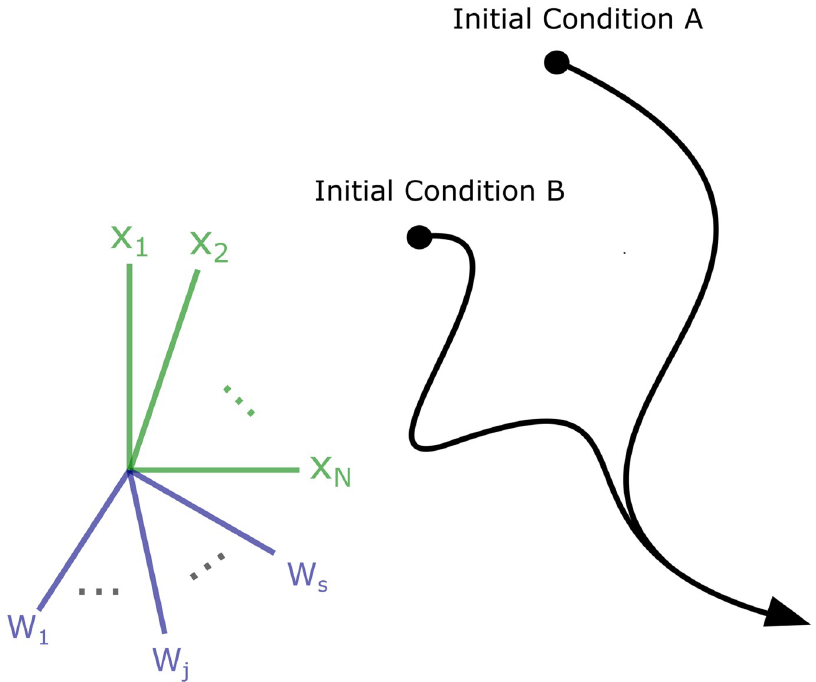
Fig 1. Cartoon demonstrating the contraction property. In a network with N neural units and S dynamic synaptic weights, the network activity can be described a trajectory over time in an ( N + S )-dimensional space. In a contracting system all such trajectories will converge exponentially in some metric towards each other over time, regardless of initial conditions. In other words, the distance between any two trajectories shrinks to zero—potentially after transient divergence (as